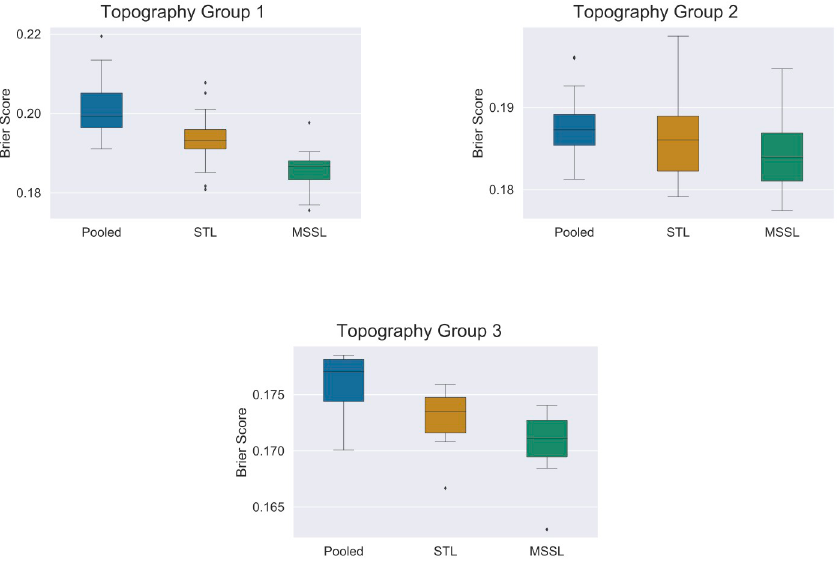
Fig 1. Brier score (y-axis) performance by classifiers (pooled, STL, and MSSL). Results show the aggregated performance from all tasks. Boxplots are composed of the mean Brier score over all 30 independent runs. MSSL shows superior performance in all three tasks splitting